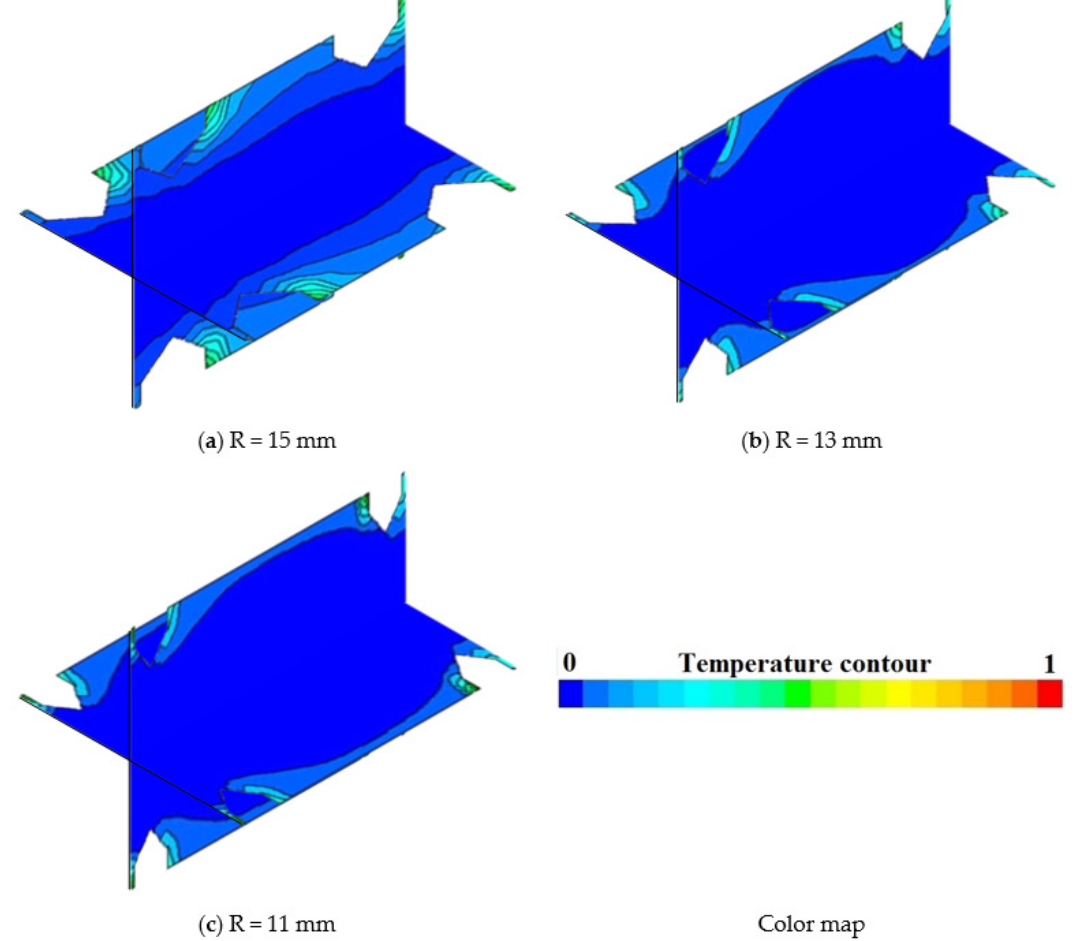
Figure 13. Temperature contours for various configurations of Case B with different R parameters at B 2 = 24 mm, Re = 15,000, and ϕ =